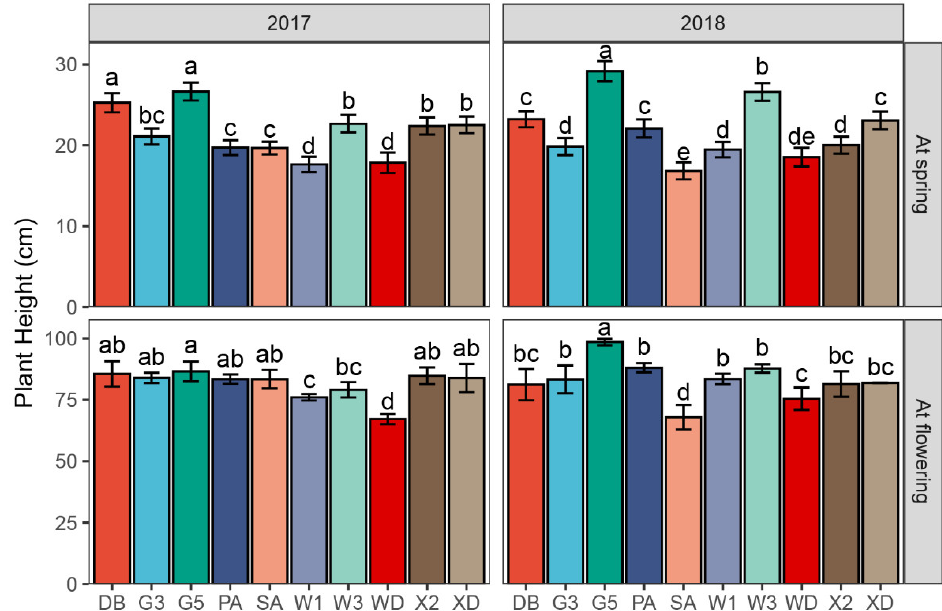
Figure 4. The plant heights of 10 alfalfa varieties at spring and at flowering of first cutting in 2017 and 2018. Different letters indicate significantly different means at p < 0.05. Error bars indicate the standard deviation of the means. DB: Derby, G3: Gannong No. 3, G5: Gannong No. 5, PA: Phabulous, SA: Sanditi, W1: WL168HQ, W3: WL343HQ, WD: Wudi, X2: Xinmu No. 2, XD: Xinjiang Daye.